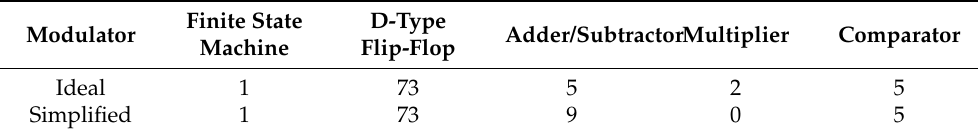
Table 7. Resources used in the FPGA for the different modulators.